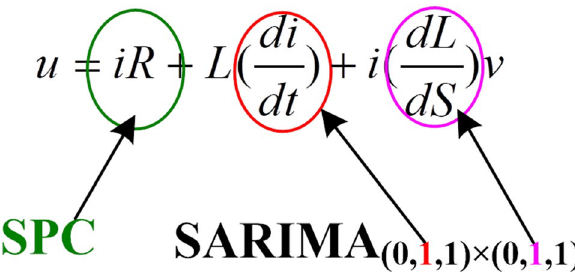
Figure 5. The correspondent relationships among the DC power supply voltage, SPC, and SARIMA